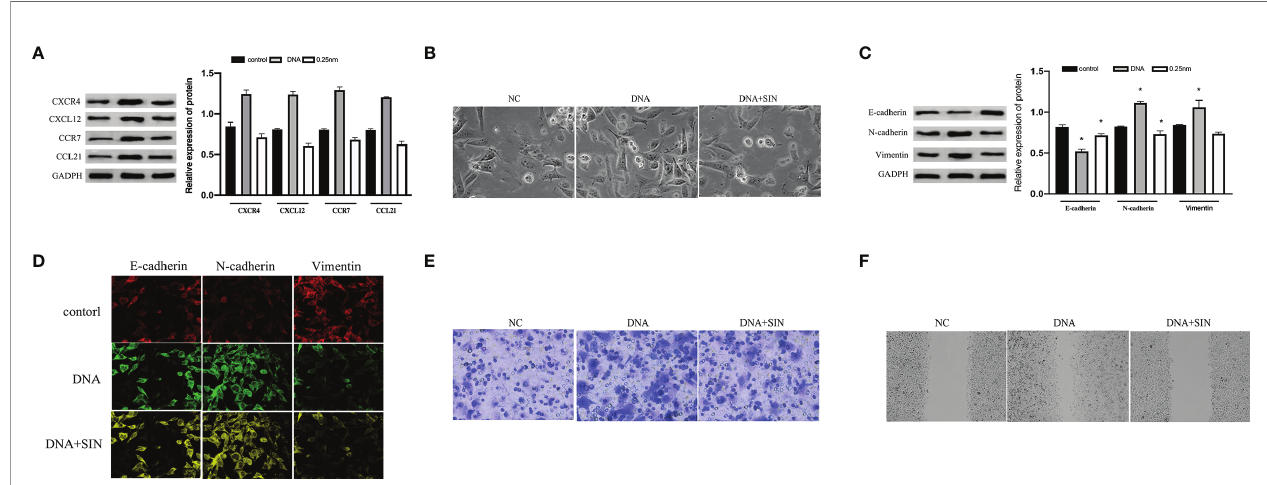
FIGURE 5 | Tumor-derived DNA can activate the CXCL12-CXCR4 and CCL21-CCR7 axes of HCC cells, while sinomenine hydrochloride has the effect of inhibiting the CXCL12-CXCR4 and CCL21-CCR7 axes of HCC cells. (A) The protein expression of CXCL12, CXCR4, CCL21, and CCR7 was examined by Western blot (WB) analysis after transfection of tumor-derived DNA. (B) Cytomorphological analysis (×200). (C) WB assay to examine the expression of E-cadherin, N-cadherin, and vimentin. (D) Immuno fl uorescence for E-cadherin, N-cadherin, and vimentin (×200). (E) Transwell analysis of HCC cell invasion (×200). (F) Scratch assay to examine HCC cell migration (×200). *P <